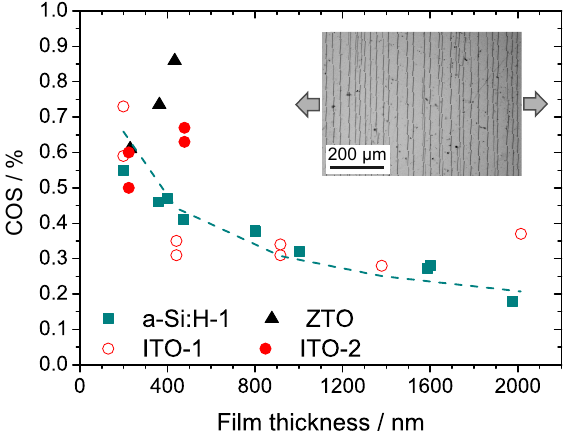
Figure 5. Crack onset strain (COS) for single films of a-Si:H, ITO-1, ITO-2, and ZTO with varying film thickness on 25µm PET substrates. The dashed line indicates the proportionality of the critical strain and 1/ (cid:112) t f for a-Si:H coatings. The inset shows an example of channeling cracks in a ca. 400nm ITO-1 film. Arrows indicate the direction of the applied tensile